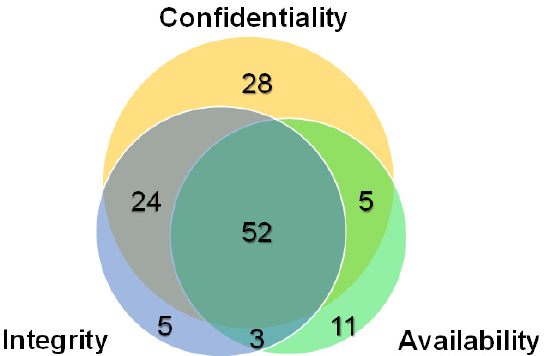
Figure 6. Breakdown of the security characteristics (adopted from [247] with updates of